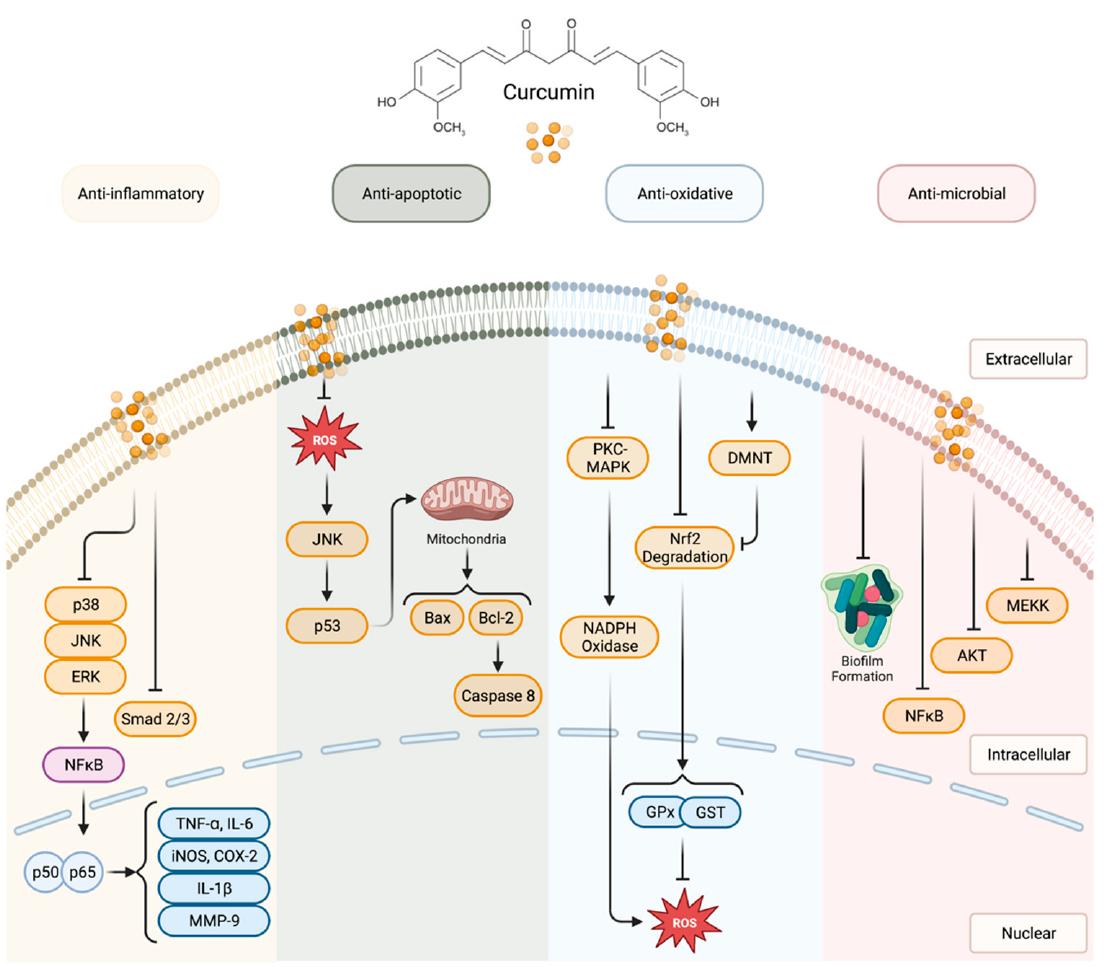
Figure 1. Schematic of the biological mechanisms of curcumin, including anti-inflammatory, anti- apoptotic, anti-oxidative, and anti-microbial pathways. Created with Biorender.com.